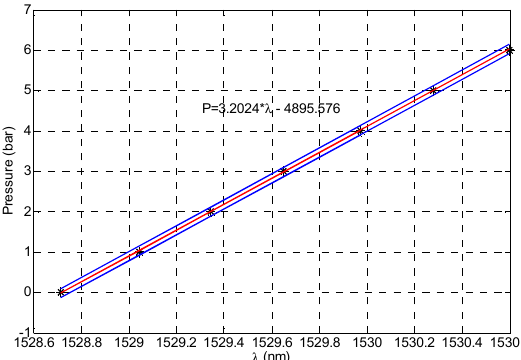
Figure 1. ( a ) The optical pressure sensor; ( b ) The two FBG sensors bonded on the stainless steel membranes; ( c ) a top view of the sensor during the assembly phase; ( d ) the FBG sensor mounted on the experimental setup.